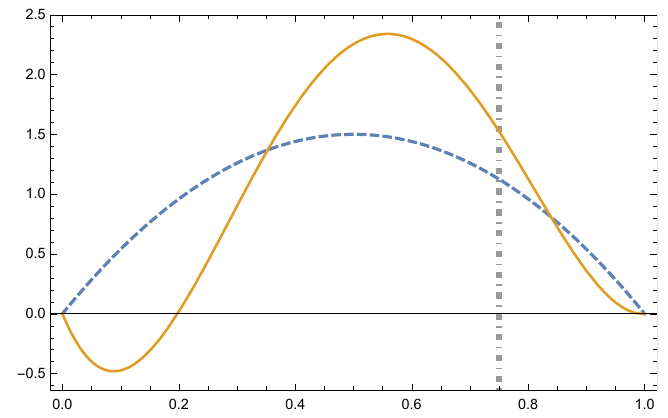
q 2 used here is deduced by G-K relation. The h i P x ), while the dot-dashed line denotes the −